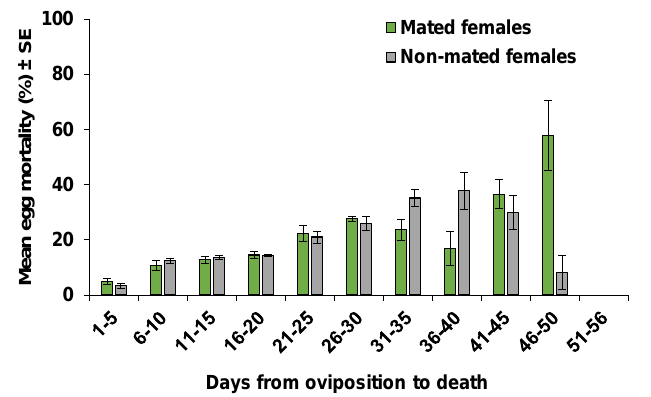
Figure 6. Mean ( ± SE) percentage of egg mortality in the progeny of all mated (n = 22) and non-mated (n = 19) females of Ooencyrtus lucidus on Bagrada hilaris eggs at five-day intervals from oviposition to